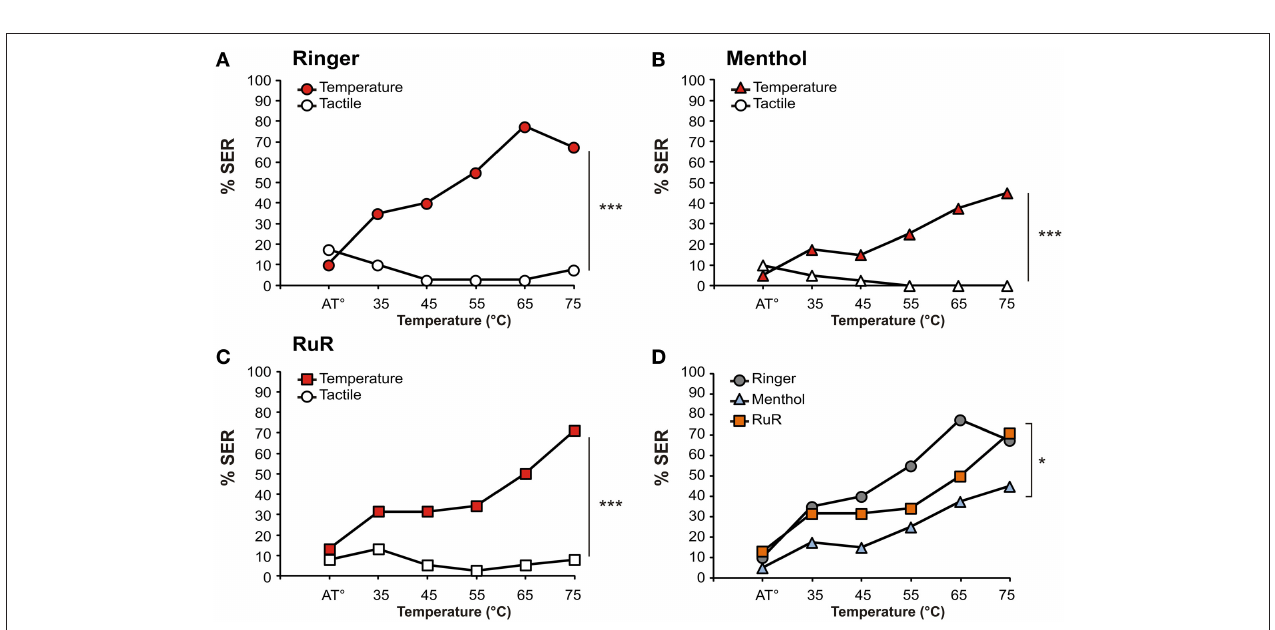
FIGURE 7 | Effect of HsTRPA inhibitors on thermal responsiveness. Different groups of bees were injected with Ringer as control ( A ) or with an HsTRPA inhibitor, either menthol (5mM; B ) or ruthenium red (RuR, 1mM; C ) SER was measured in response to increasing temperatures (red) alternated with tactile controls (white). (D) Comparison of thermal response curves among the three groups (Ringer: gray circles; menthol: light blue triangles; RuR: orange squares). Both inhibitors decreased heat responsiveness ( * p < 0.05 ; *** p < 0.001 ).